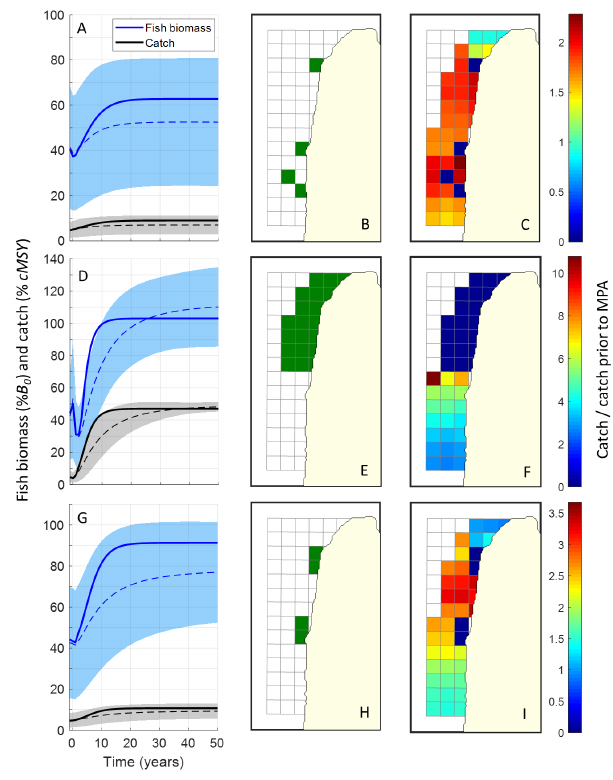
Fig. 2. Coral trout fish population biomass and catch predicted Fig. 3. Coral trout fish population biomass (A) and fishery for alternative marine protected area (MPA) designs. (A–C) catch (B) predicted for alternative marine protected area (MPA) Initial community-proposed MPA design. (D–F) Theoretically designs. Within panels, bars represent the initial community- optimal MPA design. (G–I) Community-revised MPA design. proposed (Proposed), theoretically optimal (Optimal), and Leftmost panels (A, D, G) show temporal trends following community-revised (Revised) MPA designs (see also Fig. 2). MPA enforcement, with solid lines representing best estimes and dashed lines and shaded areas representing means and associated standard deviations across simulated parameter ranges. Center panels (B, E, H) highlight the placement of individual no-take reserves. Rightmost panels (C, F, I) show the distribution of projected catch relative to catch before MPA enforcement, with values > 1 highlighted in warm colours, indicating local fishery benefits. Abbreviations: B , unfished 0 biomass; cMSY, community maximum sustainable yield.